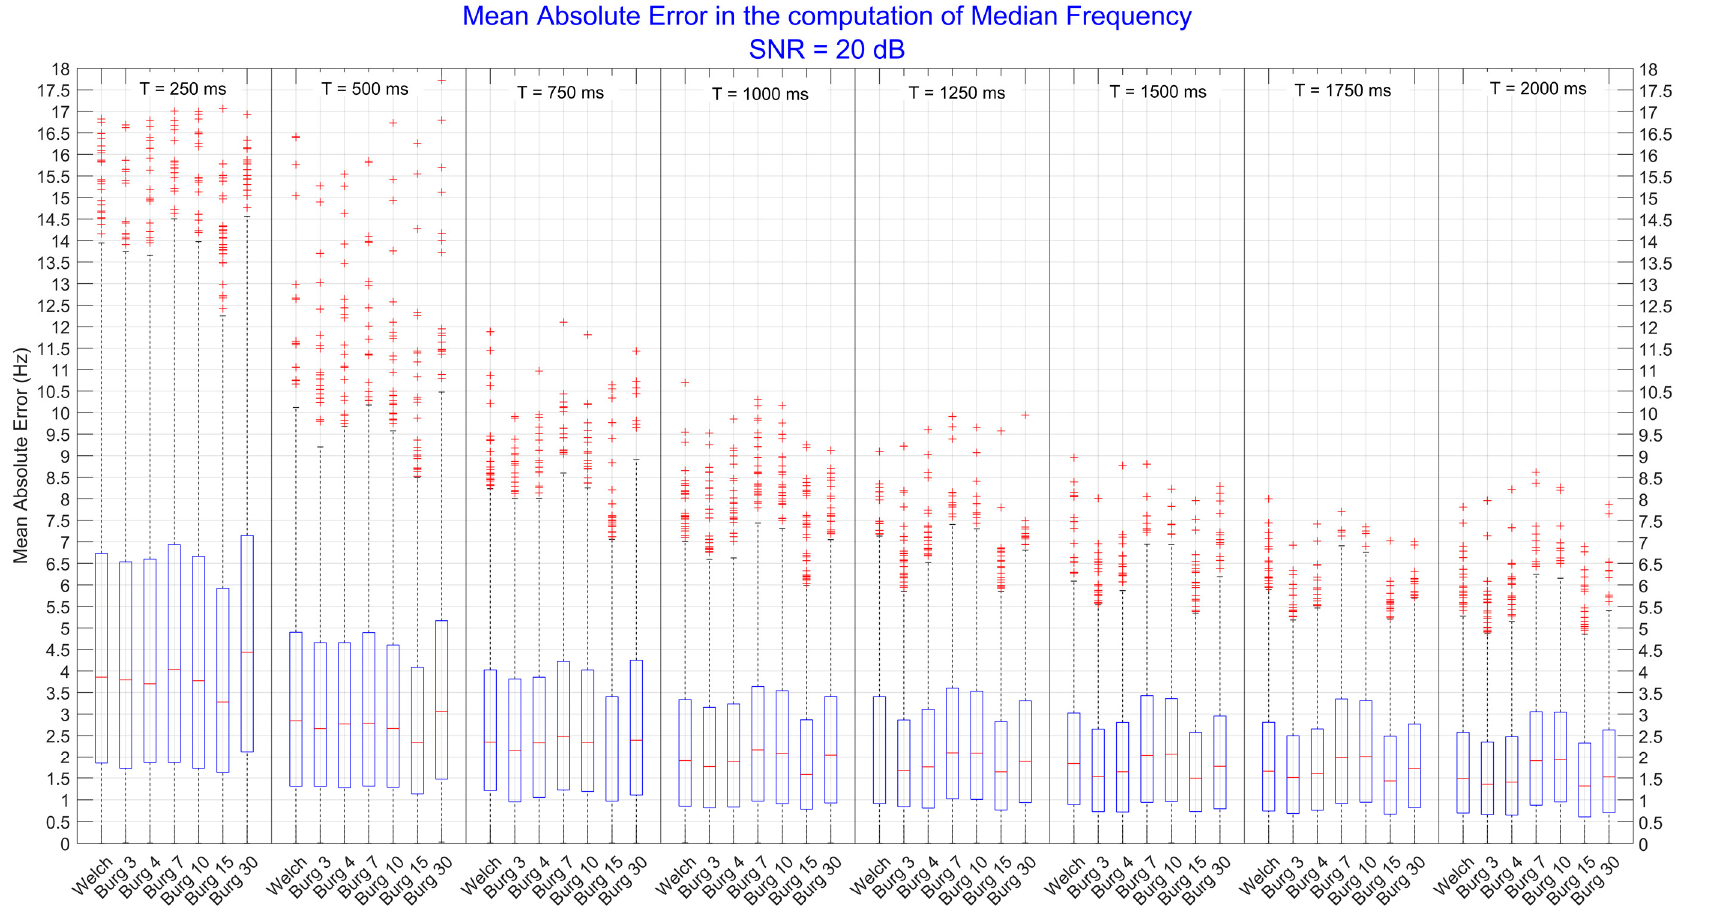
Figure 5. Mean absolute error computed on the median frequency parameters. All values were extracted from power spectral densities that were estimated by Welch and Burg methods. The figure is divided in 8 subgroups (separated by vertical lines) representing the levels of the duration factor. Each represented subgroup was computed when the signal-to-noise ratio was high (20 dB). The significance level was set at p < 0.05. The 15th order produces the minimum error but the mean differences with the error produced by the other orders and Welch were not significant ( p < 0.05).